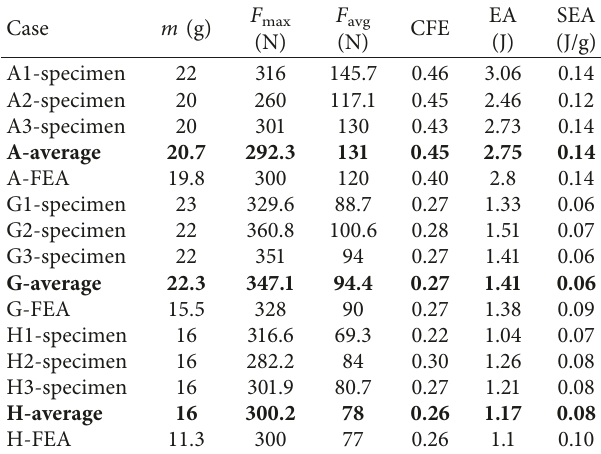
Table 6: Different layer thicknesses for FEA and experimental results.